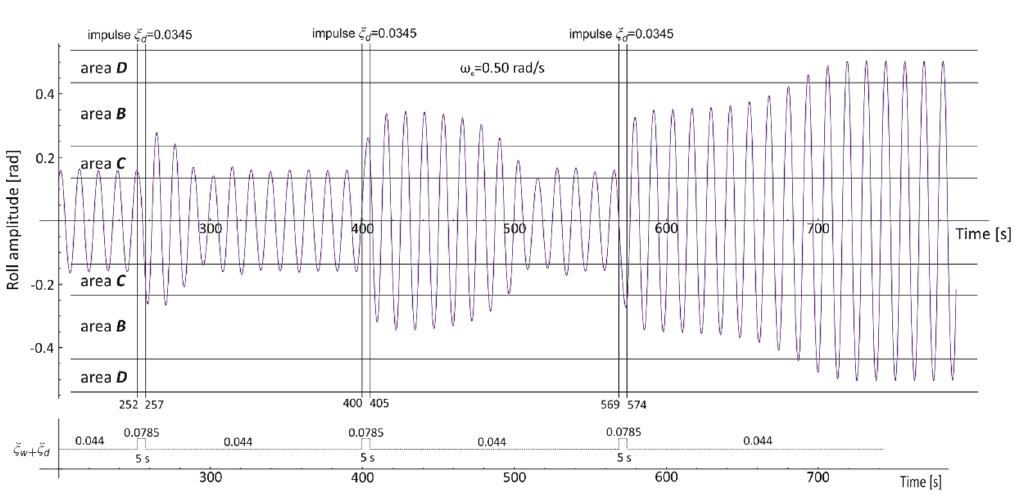
10 of 13 Figure 10. Roll time history for the OSV vessel (T = 6.10 m, GM0 = 2.50 m, ξ w,(a) = 0.0498, ξ w,(b) = 0.0482). The transition from the bistability area C to the resonance area D is caused by the additional exciting